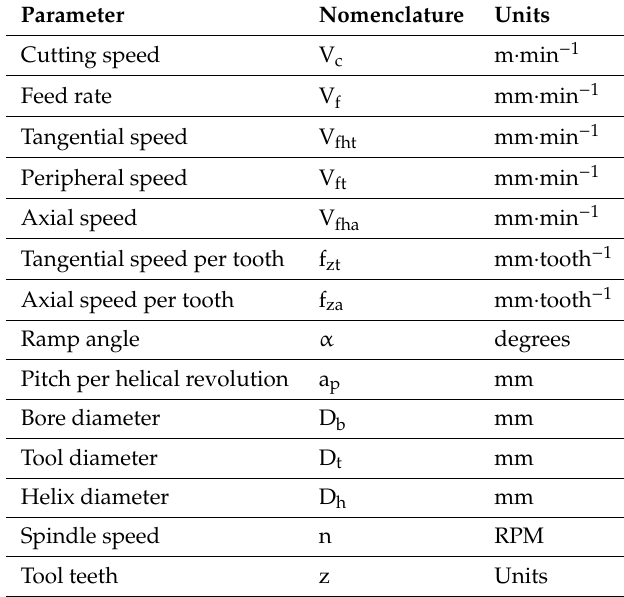
Table 1. Proposed Nomenclature for kinematic parameters of the helical milling